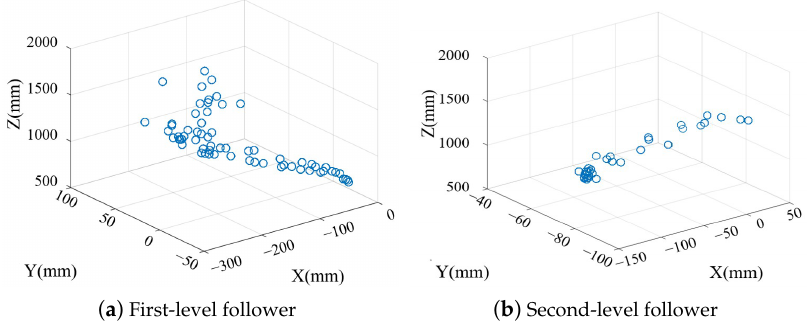
Figure 25. Three-dimensional coordinates measured by the vision of the first-level follower robot and the second-level follower robot over time.